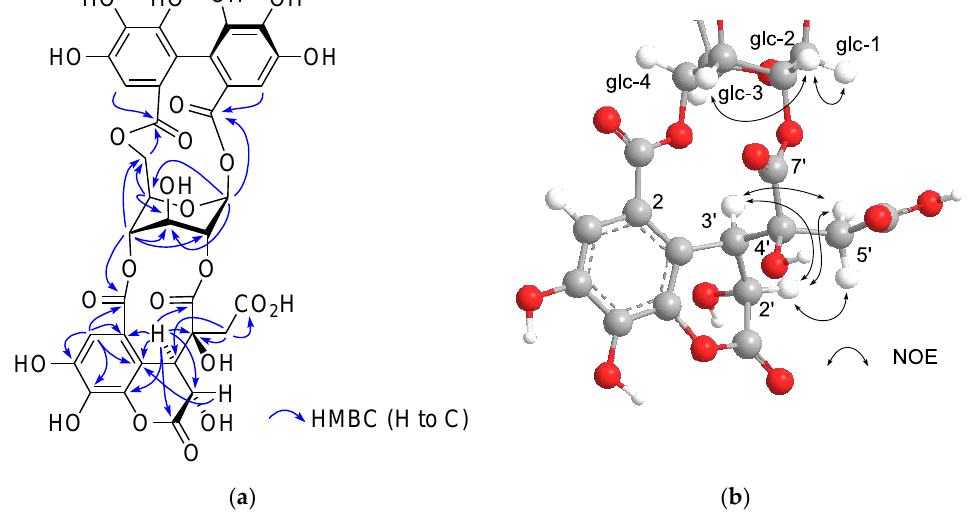
Figure 5. ( a ) Structure and selected HMBC correlations for 11 . ( b ) A partial structure of the most stable conformer of 11 and nuclear Overhauser effect spectroscopy (NOESY) correlations of the glucose and 2,4-acyl group.